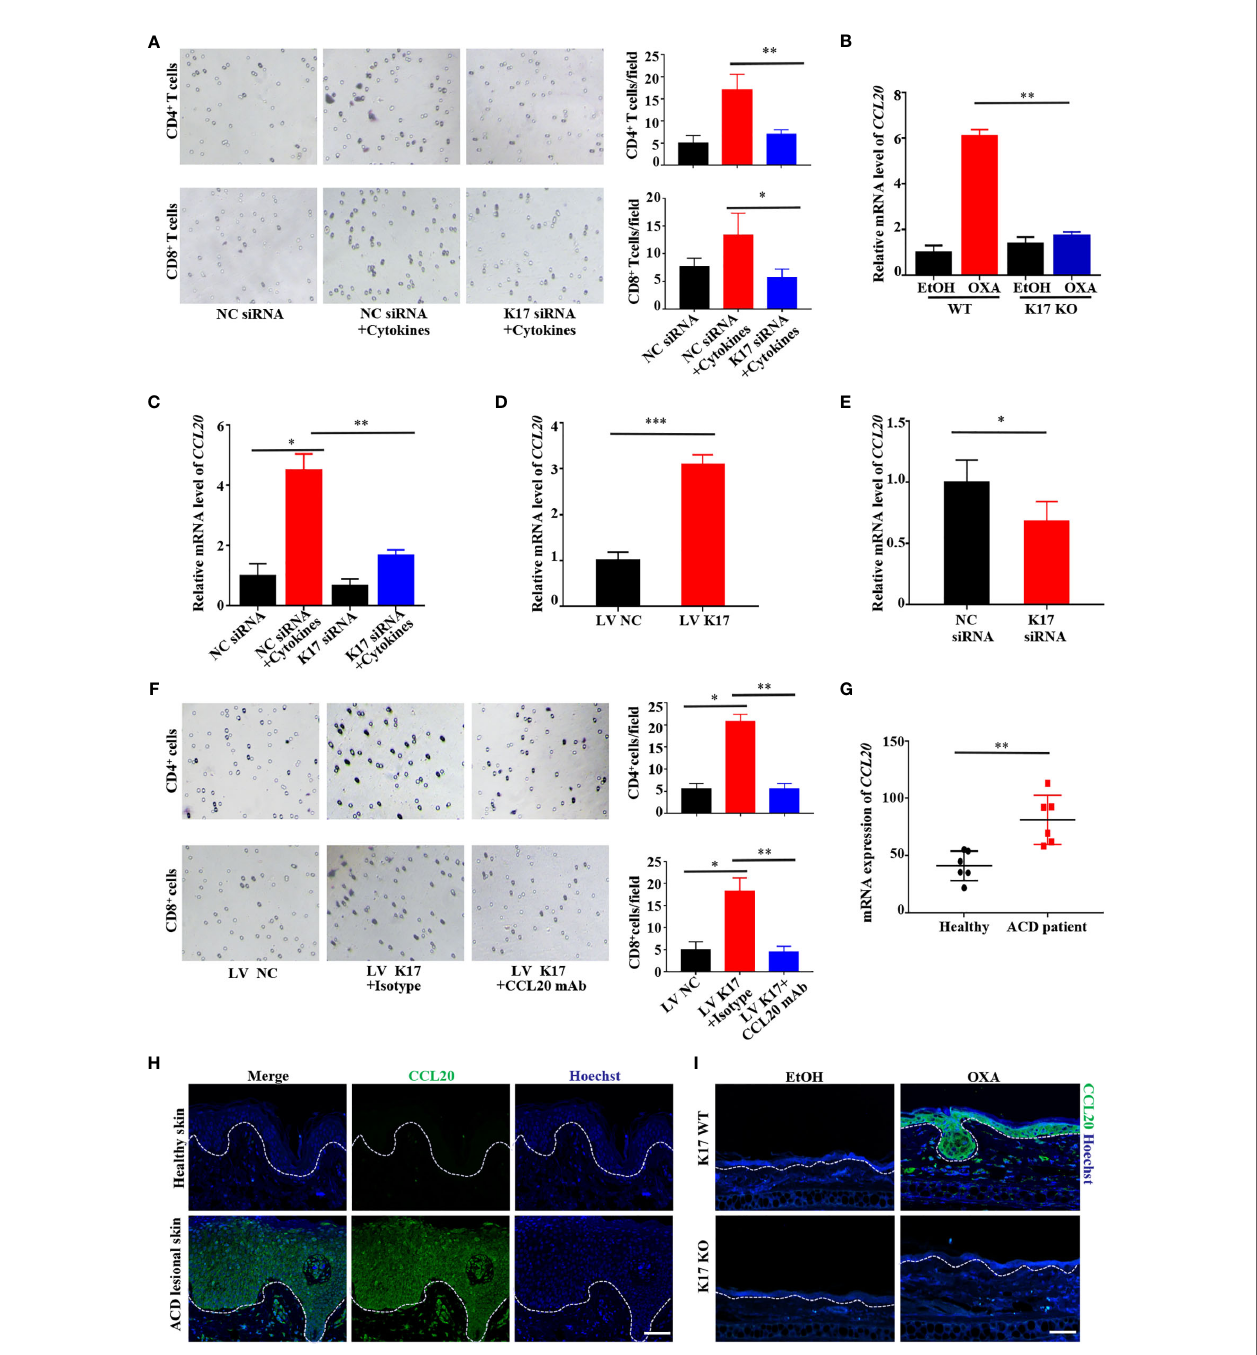
FIGURE 3 | K17 induces keratinocyte-mediated T cell chemotaxis by upregulating CCL20 expression in keratinocytes. (A) The chemotaxis effect of K17 was determined by performing crystal violet staining of the lower Transwell membrane in cytokine- and K17 -siRNA-treated HaCaT cells. (B) Relative mRNA expression of CCL20 in K17 KO and WT mice treated with OXA, n = 3 (mean ± SD). (C) Relative mRNA expression of CCL20 in cytokines- and K17-siRNA-treated HaCaT cells. (D, E) Relative CCL20 expression in HaCaT cells treated with pCMV6-XL5-K17 (LV K17) or K17 siRNA was analyzed by qRT-PCR. (F) The chemotaxis effect of K17 was determined by performing crystal violet staining of the lower Transwell membrane in K17-overexpressing cells. (G) Gene-expression pro fi le in the GEO dataset (GSE60028) was analyzed for the mRNA expression of CCL20 in ACD patients ( n = 6) and healthy controls ( n = 6). (H) Immuno fl uorescence staining for CCL20 (green) and Hoechst (blue) in lesional skin from ACD patients ( n = 4) and healthy individuals ( n = 4). Scale bar, 50 m m. (I) Ear sections from K17 KO or WT mice challenged with OXA or ethanol as a control were stained with CCL20 (green) and Hoechst (blue). Scale bar, 20 m m. Data represent the mean ± SD. * p < 0.05, ** p < 0.01, *** p < 0.001. All experiments were repeated for at least three